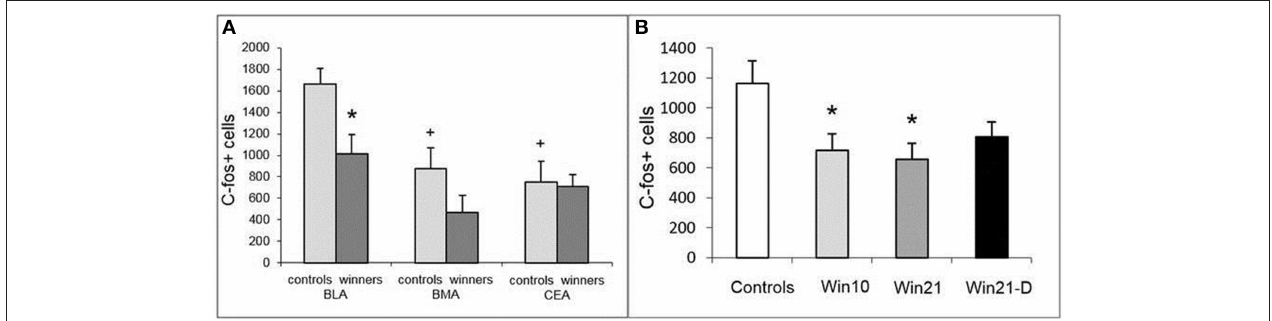
FIGURE 5 | c-fos-Positive cells in the amygdala of male mice after 21 days of agonistic interactions. (A) c-fos cells in different regions of the amygdala of control and winning C57BL/Icg male mice: BLA, basolateral amygdala; BMA, basomedial amygdala; CEA, central amygdala. (B) c-fos cells in the basolateral amygdala (BLA) of C57BL/Icg male mice with different fighting experience: Win10, 10 day winners; Win21, 21 day winners; Win21-D, 21 day winners after 2 weeks of fighting deprivation. * P < 0.05 vs. the controls, + P < 0.01 vs. controls in BLA; t